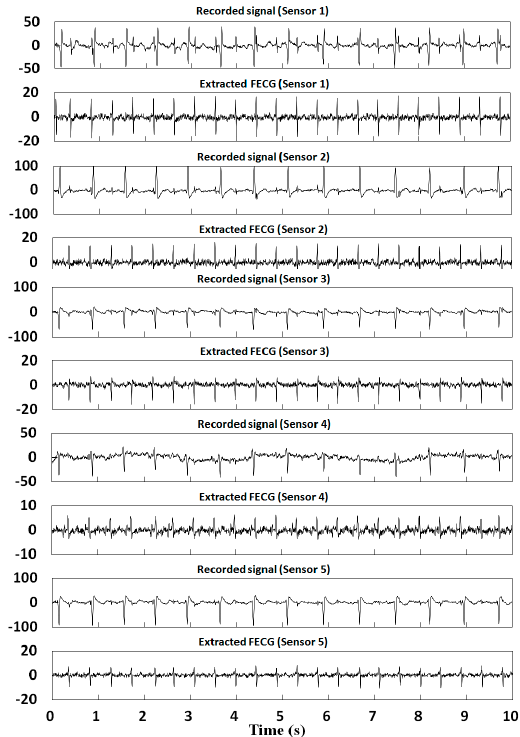
Figure 11. Extraction results from abdominal signals for Channels 1–5 in the DaISy database.